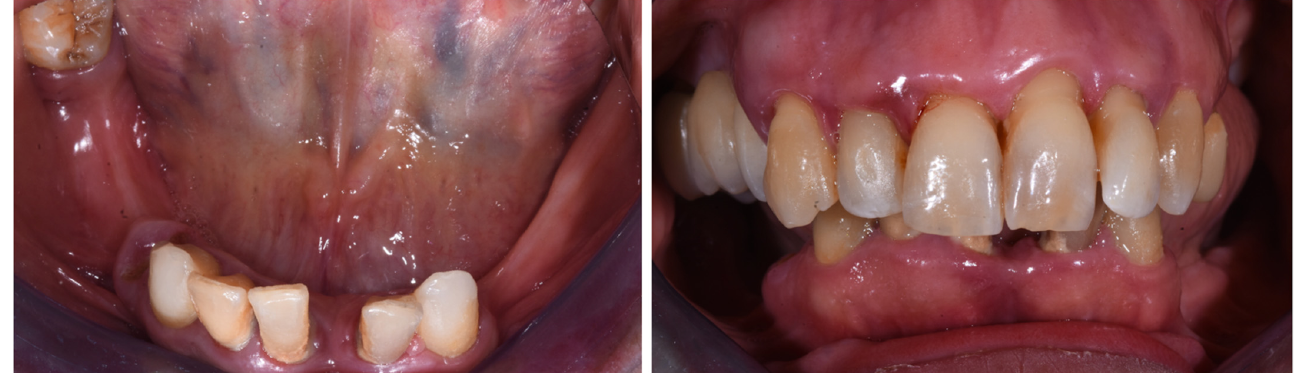
Figure 1. Mandibular assessment. Left: Occlusal view. Right: Frontal view (January 2020).